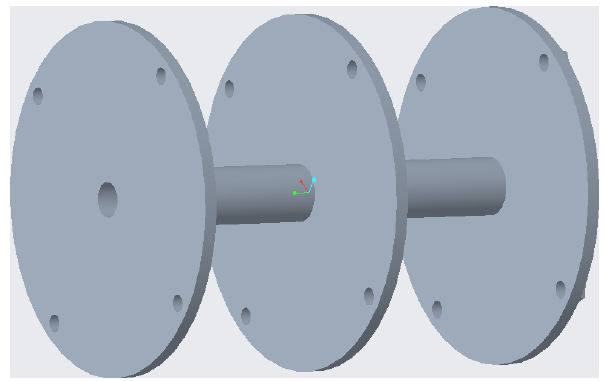
Figure 4. Model diagram of the hammer framework.